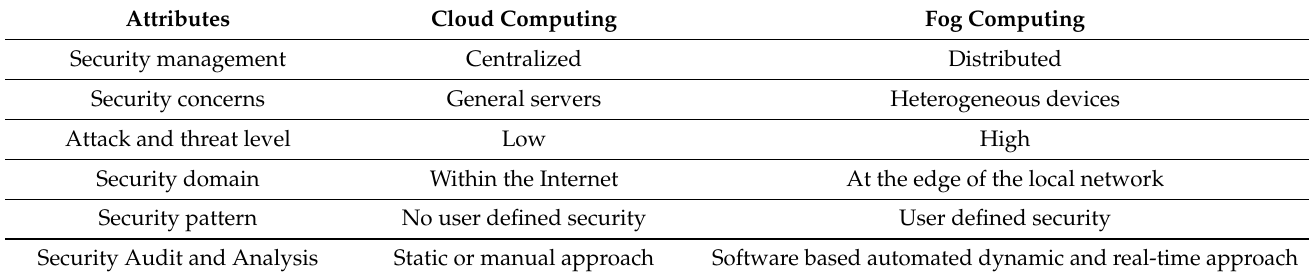
Table 4. Technical difference between Fog and cloud in a security perspective.